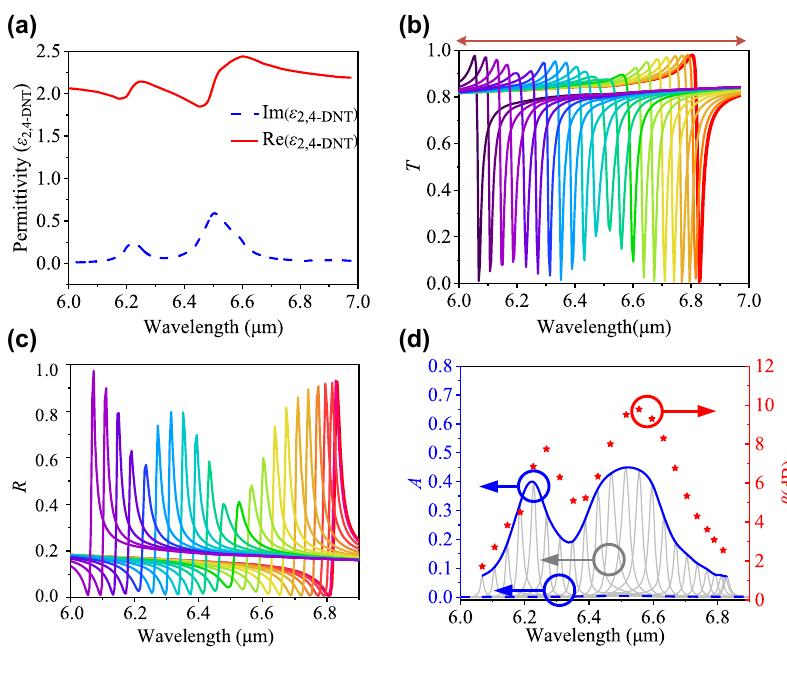
Figure 6: Permittivity of 2, 4-DNT and its detectionresults.(a)Realpartandimaginary part of permittivity of 2, 4-DNT (b) and (c) are transmission and reflection spectra under incident light from 0 ◦ to 11 ◦ with a step size of0.5 ◦ .(d)Absorbancespectraandenhance- mentfactorsofproposedmetasurfacesensor with 2, 4-DNT